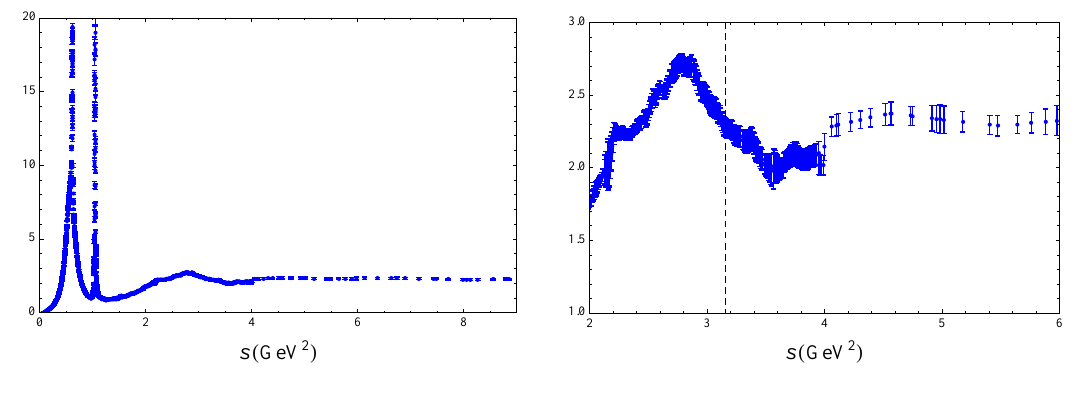
Figure 1: Left panel: R -ratio data from Ref. [ 2 ] , as a function of s , the hadronic invariant squared mass. The three-flavor, massless parton-model value is 2. Right panel: A blow-up of the region 2 ≤ s ≤ 6 GeV 2